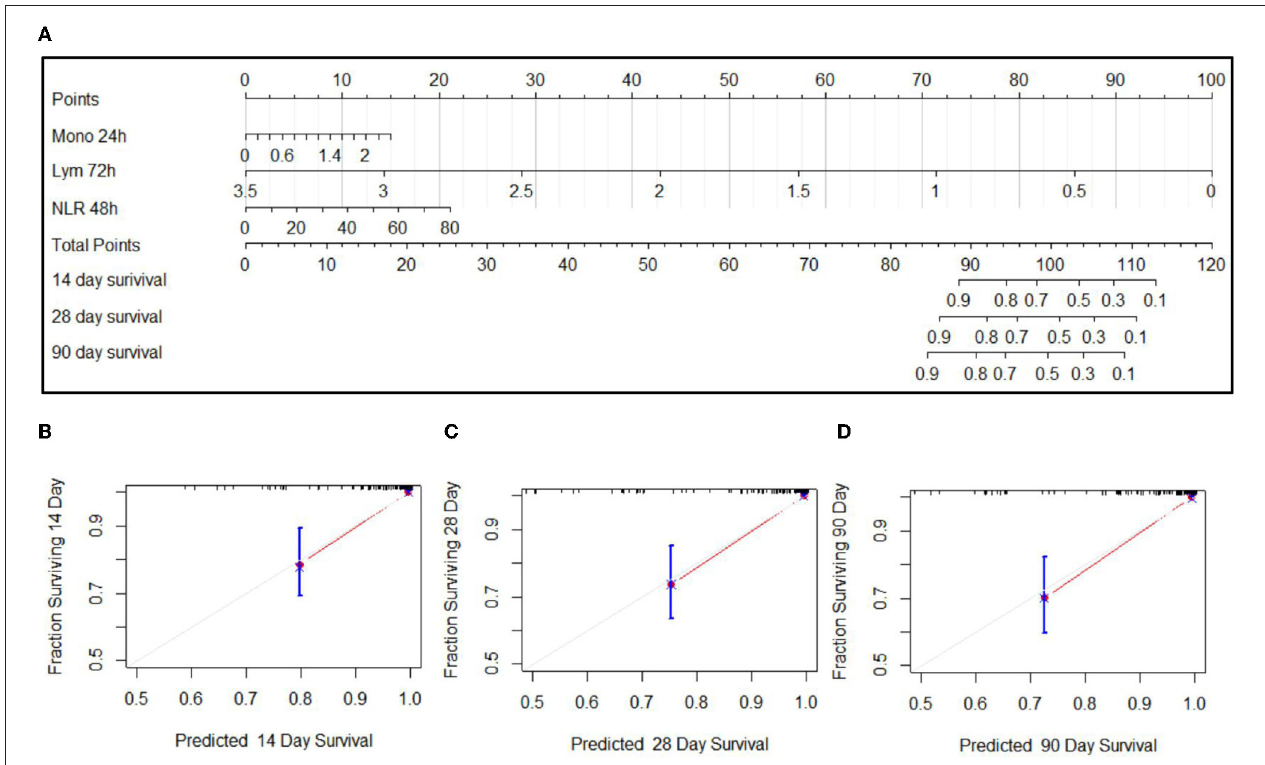
FIGURE 4 | Nomogram for the predication on 14-day, 28-day, and 90-day prognoses of EHS (A) and calibration curves of 14-day (B) , 28-day (C) , and 90-day (D) of